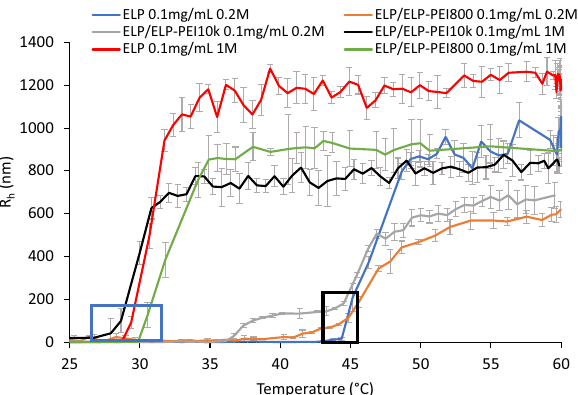
Figure 1. DLS results demonstrate single and bimodal curves can be obtained by varying the salt concentration. The second transition for the bimodal curve for the ELP-PEI10K (grey) occurs at the same point (black box) as neat ELP (blue) and ELP/ELP-PEI800 (orange), indicating that either the ELP-PEI10K transitions earlier than neat ELP or it has more than one ELP molecule conjugated to the PEI10K. The bimodality of the ELP/ELP- PEI800 (orange) and the ELP/ELP-PEI10K (grey) curves disappears with an increase in NaCl concentration to 1 M (blue box). All DLS curves were obtained at pH =